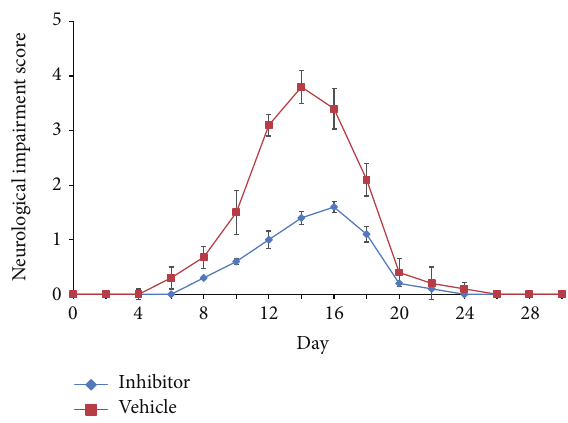
Figure 1: Neurological impairment scores in Lewis rats with experimental autoimmune encephalomyelitis (EAE). The rats were immunized with 25 𝜇 g of myelin basic protein (MBP) and 5 mg/mL of Mycobacterium butyricum and then treated with either the cPLA 2 inhibitor AX059 or vehicle once daily, starting on the day of immunization for EAE induction. EAE development in the rats was assessed on a scale of